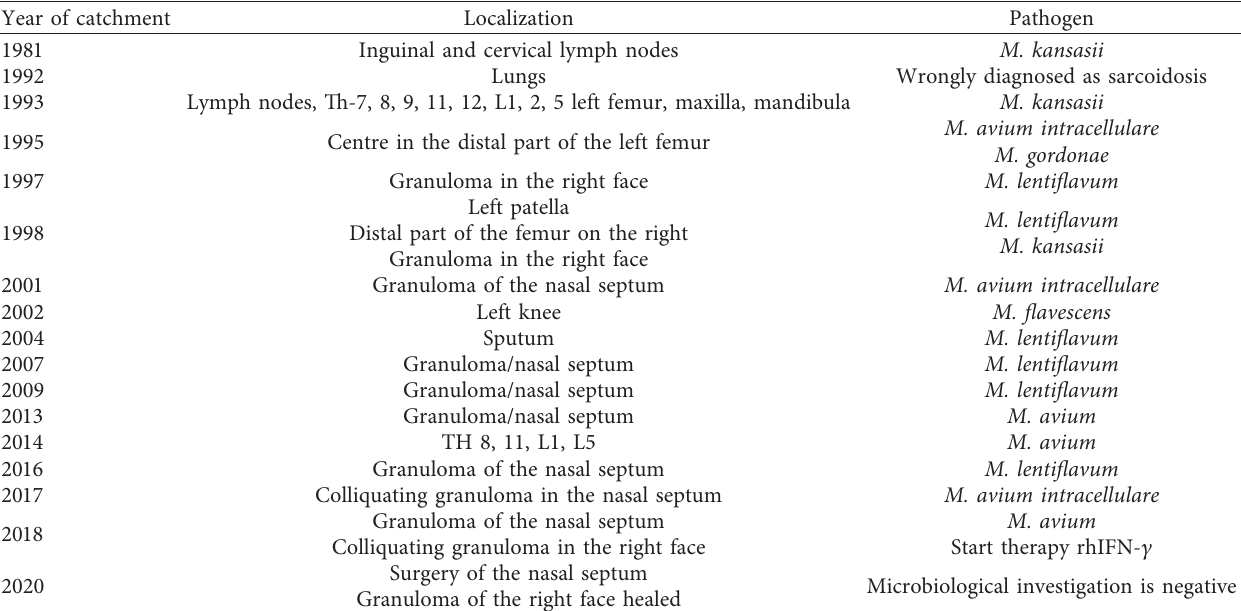
Table 2: Time sequence of clinical